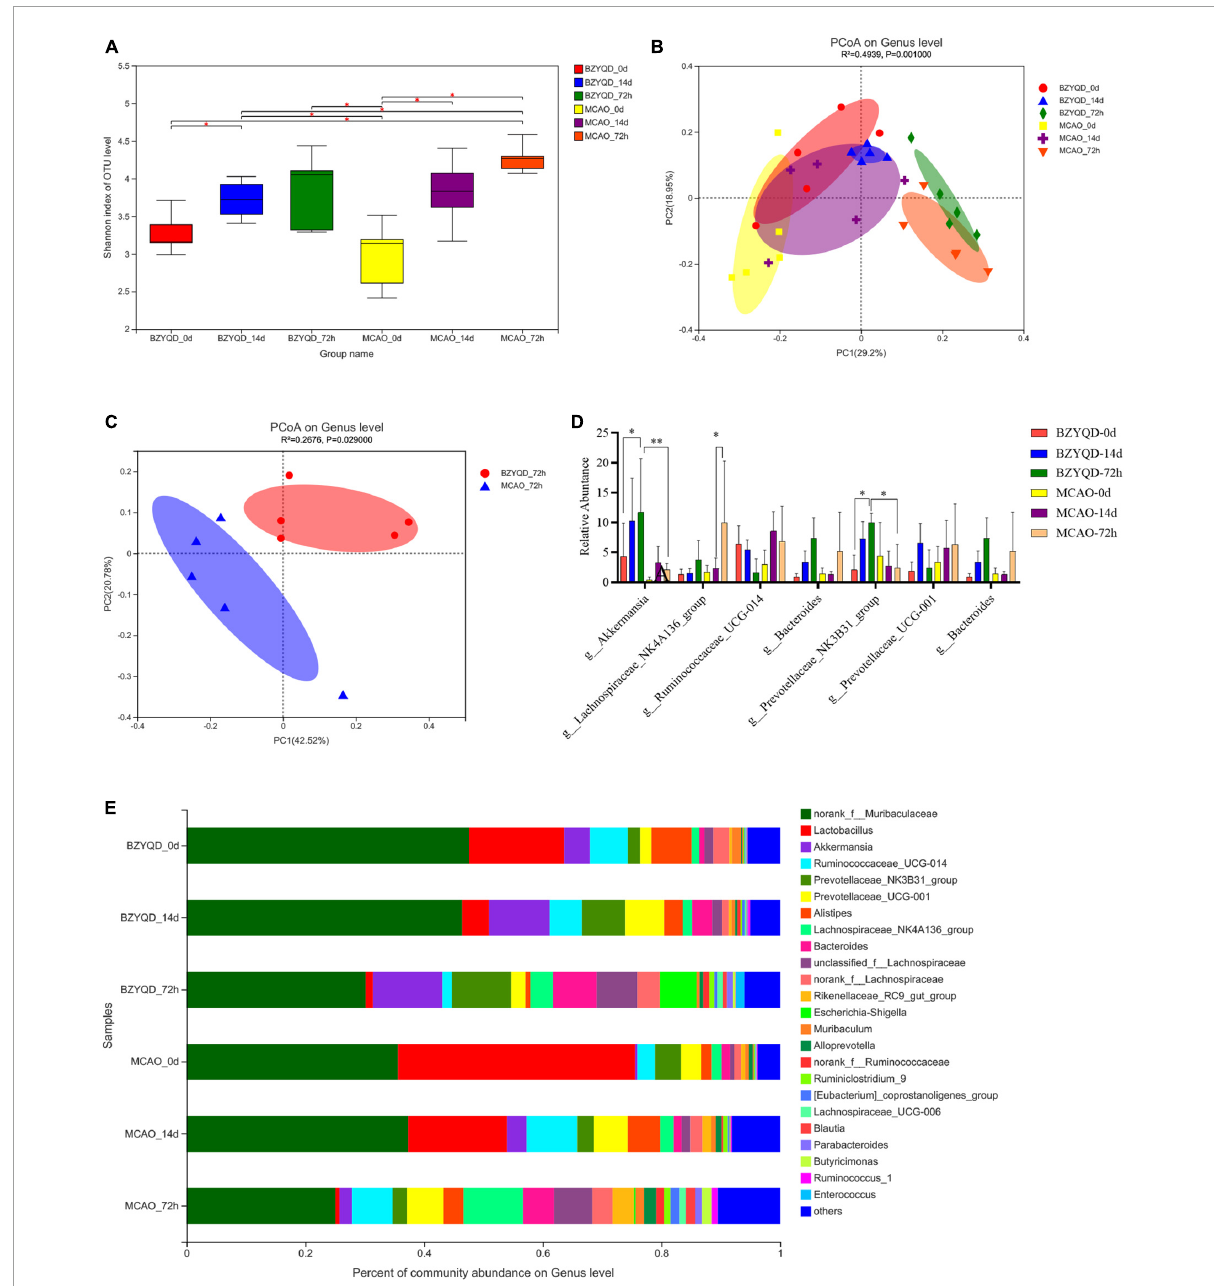
FIGURE3 The effect of the prophylactic administration of BZYQT on the intestinal flora of mice. (A) Sobs index analysis represents Alpha diversity. (B) Analysis of species composition of intestinal flora in two groups at the genus level at three time points. (C) PCoA analysis of intestinal flora 72 h after operation of the two groups. (D) The species composition of the gut microbiota at the genus level at three time points in the two groups was analyzed. (E) Relative abundance analysis of major genera at the genus level. * P < 0.05. Data are expressed as mean ± standard deviation. N =